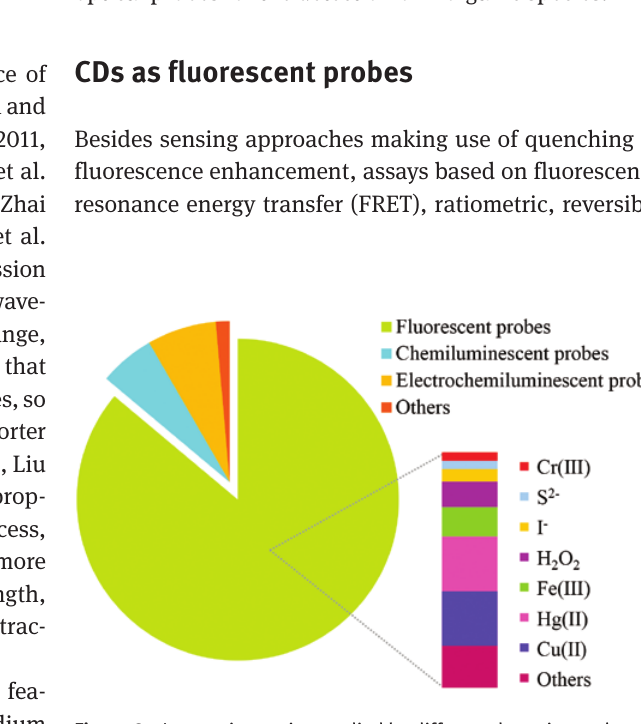
Figure 2: Inorganic species studied by different detection tech- niques involving the use of CD-based